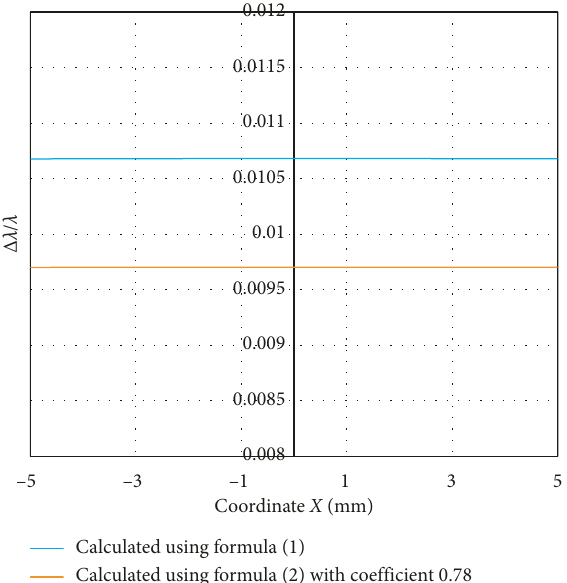
Figure 8: Estimated value surface through the adhesive layer.